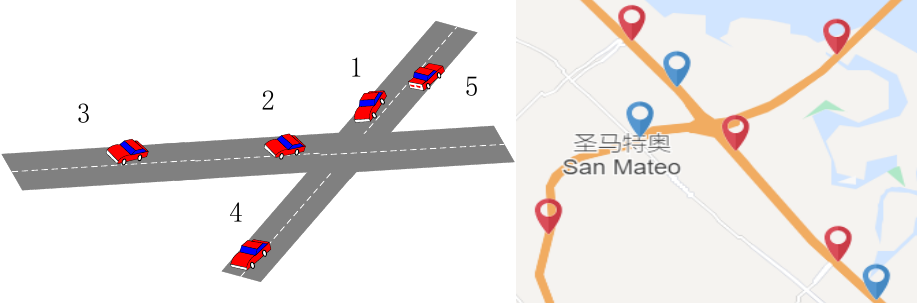
Figure 1. Simulated road intersection.